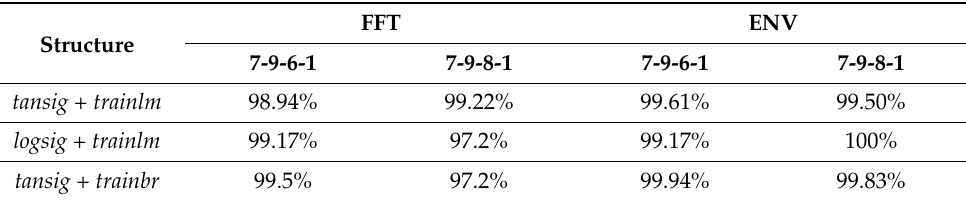
Table 4. Comparison of the effectiveness of fault classifiers (detectors type II) determining the type of damage. Structure